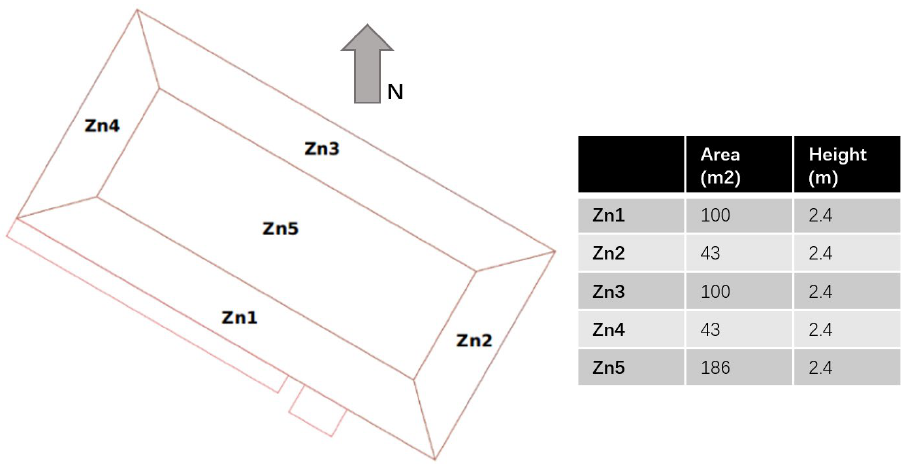
Figure 3. The training and testing building model plan. Table 3. The type of building fabrics, along with their thermal properties.